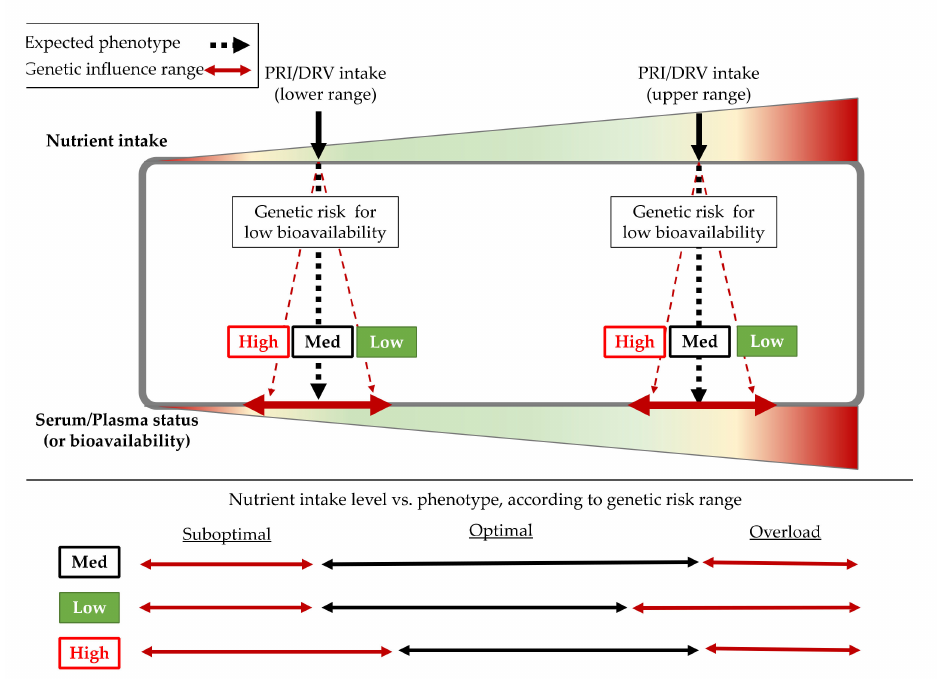
Figure 1. Genetic influence on the micronutrient intake-plasma level relationship. Abbreviations: PRI (Population Reference Intake); DRV (Dietary Reference Values); Med (medium genetic